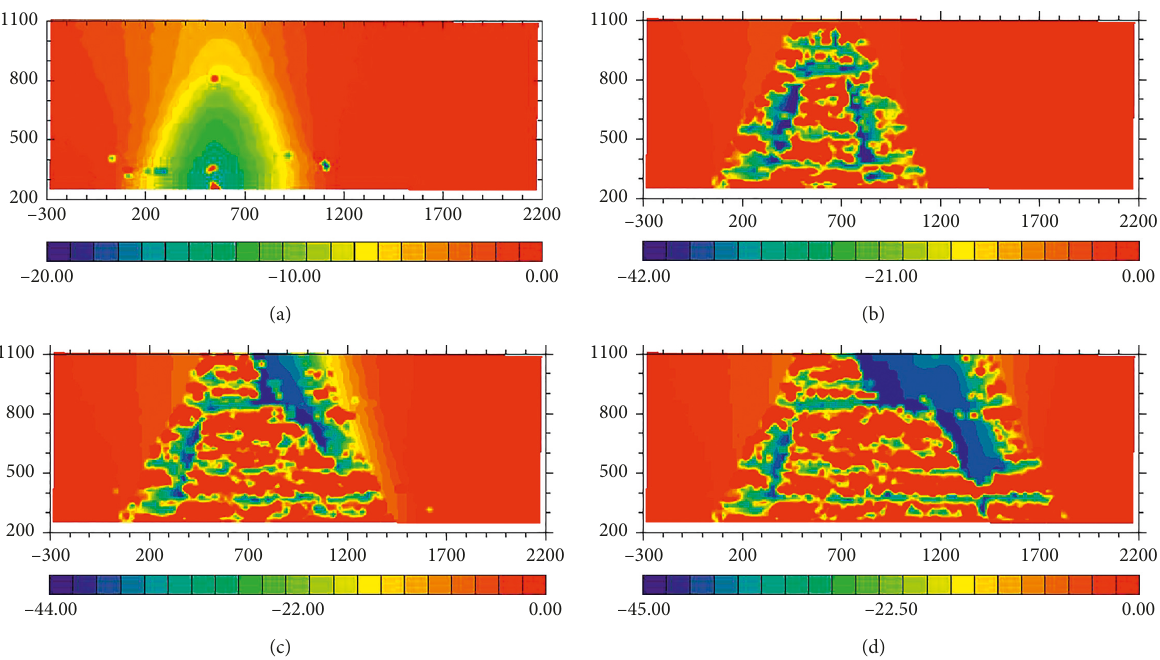
Figure 12: The distribution of vertical deformation during excavation. The coal stratum is excavated to (a) 120m, (b) 130 m, (c) 165m, and (d)